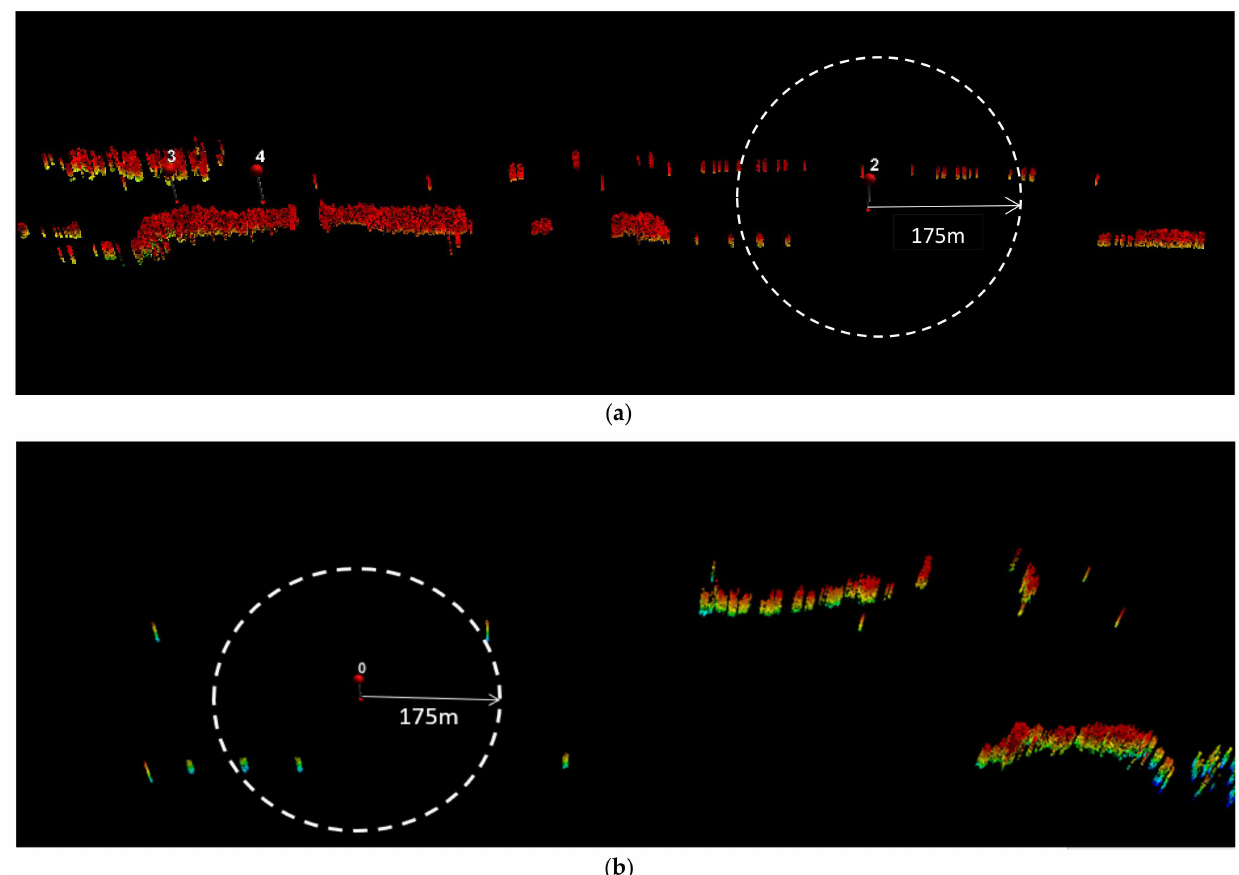
Figure 6. Roadside features within the buffer zone of collision: ( a ) collision with high density of roadside objects; ( b ) collision with low density of roadside